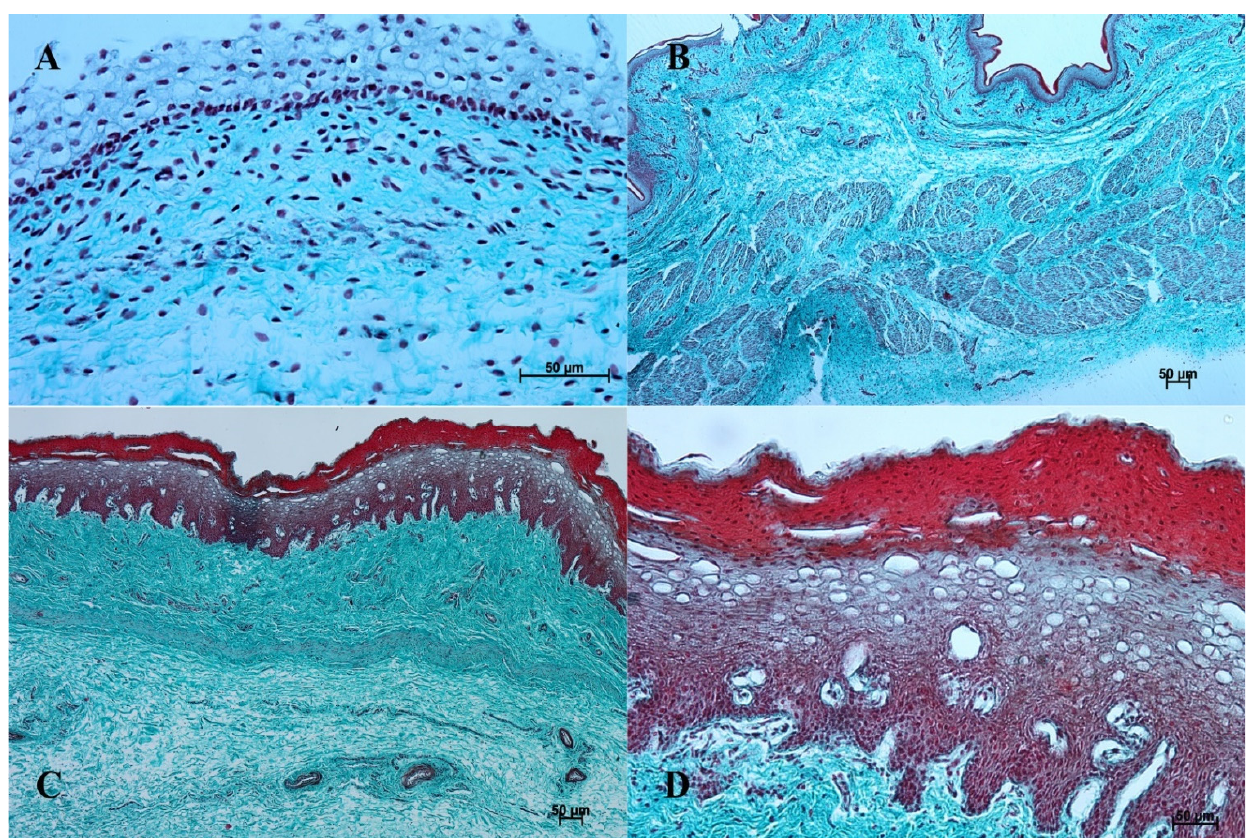
Figure 3. Histological structure of the stomach mucosa in the nonglandular part (Masson-Goldner staining). ( A )—the first age group (20×); ( B )—the second age group (40×); ( C )—the third group (20×); ( D )—the reference adult group (10×). The entire glandular mucosa was covered with a simple columnar epithelium (Figures 4A, 5A, 6A, 7A, 8A, and 9A).